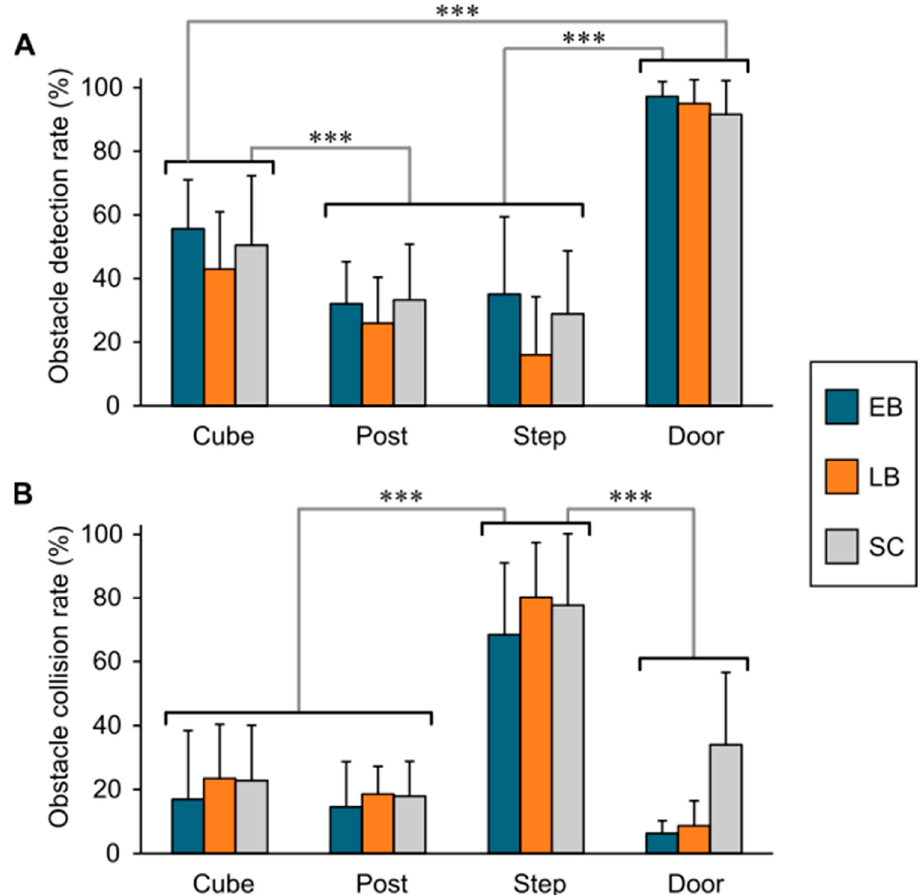
Figure 4. The average rates of obstacle detection ( A ) and collision ( B ). Significant differences are indicated by asterisks (*** = p < 0.001). EB = early blind; LB = late blind; and SC = sighted control.